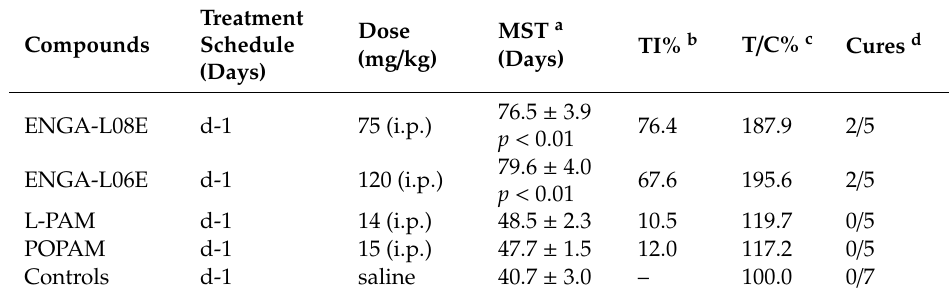
Table A3. In vivo antitumor e ff ects of compounds ENGA-L06E, ENGA-L08E, L-PAM and POPAM on SKOV-3 human ovarian adenocarcinoma xenograft bearing